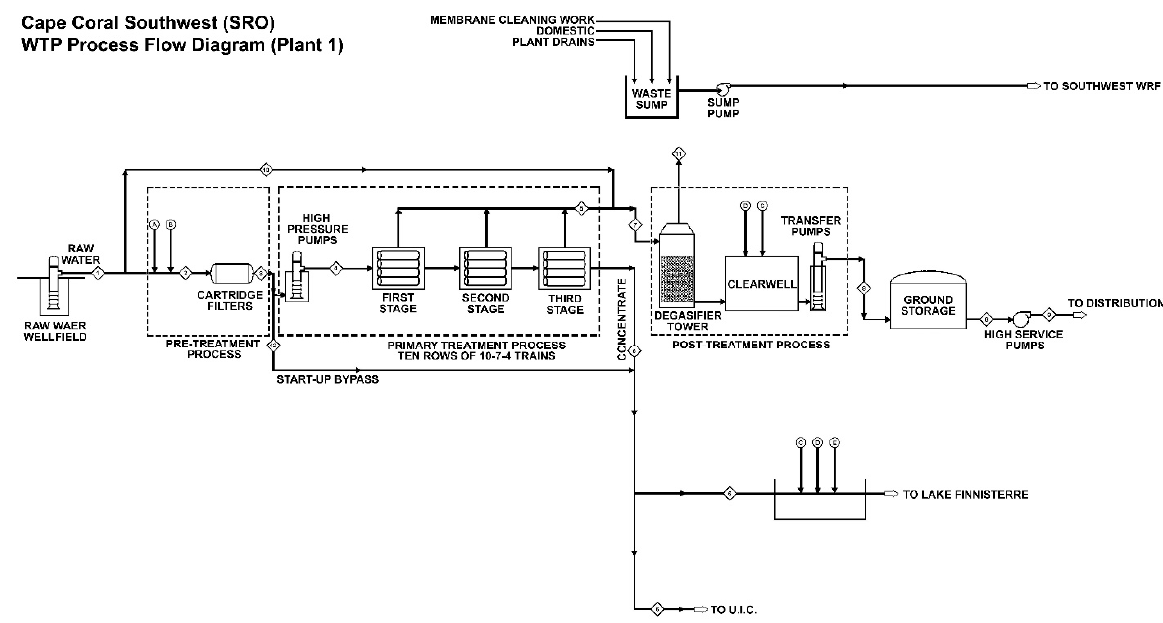
Figure 2. Process diagram for the South Cape Coral BWRO